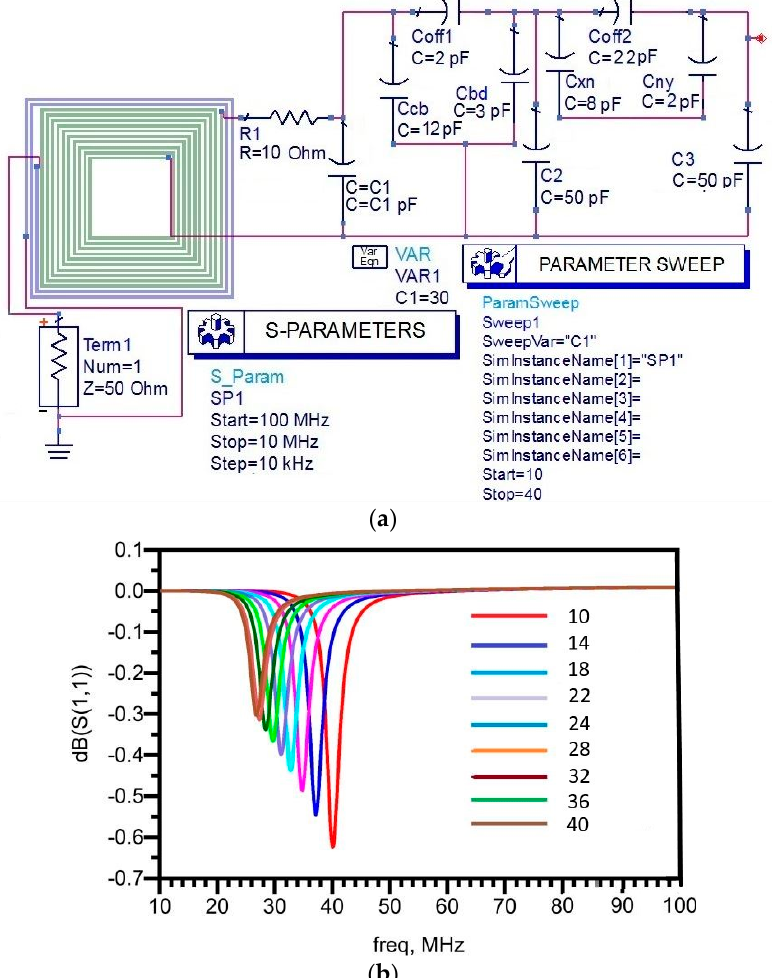
Figure 4. Layout simulations setup using ADS and results. ( a ) Simulation setup when both switches were in off-state. ( b ) Detected resonant frequencies by applying sweep parameter at C 1